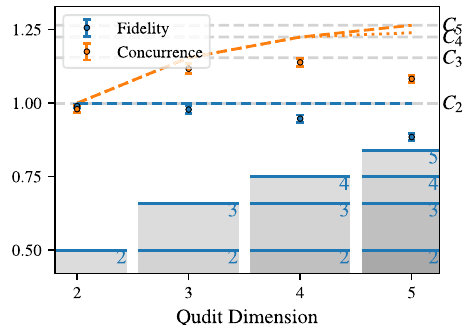
Fig. 5 | Generation of genuine qudit entanglement. The measured state fi delity for d =2,3,4,5 is shownasblue data points and the corresponding concurrenceas orange squares. The ideal values for maximally entangled states (the experimental target states) are shown as dashed (dotted) lines. The gray shaded bars represent the lower bound on the fi delity (blue data points) for certifying maximal Schmidt number entanglement, while the gray horizontal lines indicate the concurrence C d for a maximally entangled state in dimension d . Error bars correspond to one standard deviation of experimental shot Fig. 4 | Fidelity decay measured using multiple gates. a Schematic of the mea- surement sequence. Two ions initialized in ∣ 00 i are rotated into an equal super- position of all states by applying the operator P with the 729nm laser. After applyingthegateoperator G ( θ )avariablenumberoftimes n areversedpreparation pulse P † is applied. The populations of the resulting state are measured by a set of (cid:3) to transfer the transfer pulses T j 0 , which are resonant π pulses between ∣ 0 i $ ∣ j (cid:3) state ∣ j tothe S 1/2 manifold,allowingustodistinguishthequditstates.Ananalysis (cid:3) withvariablephase pulse A j 0, ϕ consistingofaresonant π /2pulsebetween ∣ 0 i $ ∣ j (cid:3) ϕ isusedto measurethe coherencebetweenthe ∣ 0 i and ∣ j levels.Combined with thetransferpulses,allpairwisecoherencescanbemeasured. b Aplotofquditgate fi delityasafunctionofdimension.Theaveragegate fi delities,shownasredcircles, are extracted from fi ts to the fi delity decay when applying multiple gates G ( θ ) between P and P † . The error bars correspond to 1 standard deviation in the fi t parameters. A quadratic curve has been fi tted to the data to highlight the empiri- callyobservedscalingofthe fi delitywithdimension.Thesimulated fi delitiesfroma detailed noise model are shown as blue diamonds, see supplementary note 2 for details.